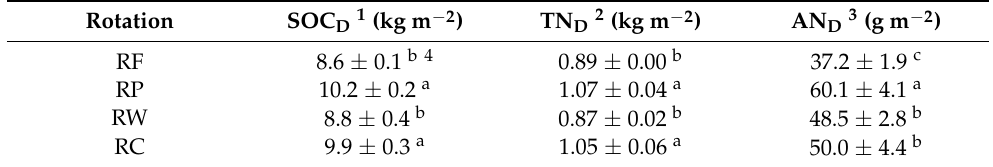
Table 2. The total soil C and N stocks within 0–50 cm soil depth under different rotation